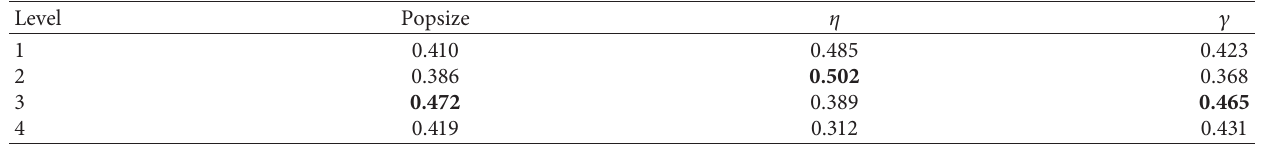
Table 3: The response value of